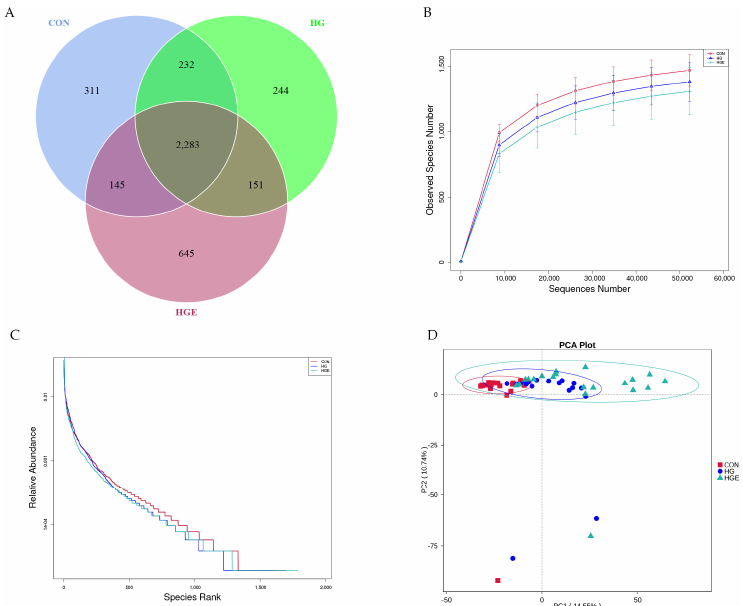
Figure 4. Ruminal microbial operational taxonomic. CON: basal diets without supplements; HG: high-grain diet; HGE: high-grain diet supplemented with 12,000 IU of vitamin E/head per day. ( A ) Venn diagram of ruminal bacterial OTUs. The number of unique OTUs was represented by the non-overlapped portion of the Venn diagram for each group. ( B ) Bacterial rarefaction curves based on OTUs were used to assess the depth of coverage for each sample. ( C ) Rank abundance curves based on bacterial OTUs were used to assess species richness and evenness in each treatment group. ( D ) Principal component analysis (PCA) of bacterial community structures of the ruminal microbiota in CON (red rectangle), HG (blue circles), and HGE (green triangle) diet groups.